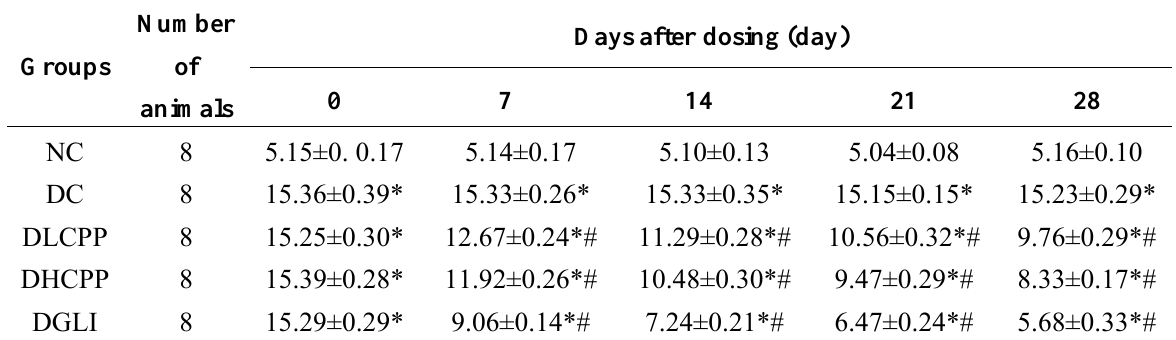
Table 2. Effect of CPP on blood glucose Level (mmol/L ) in